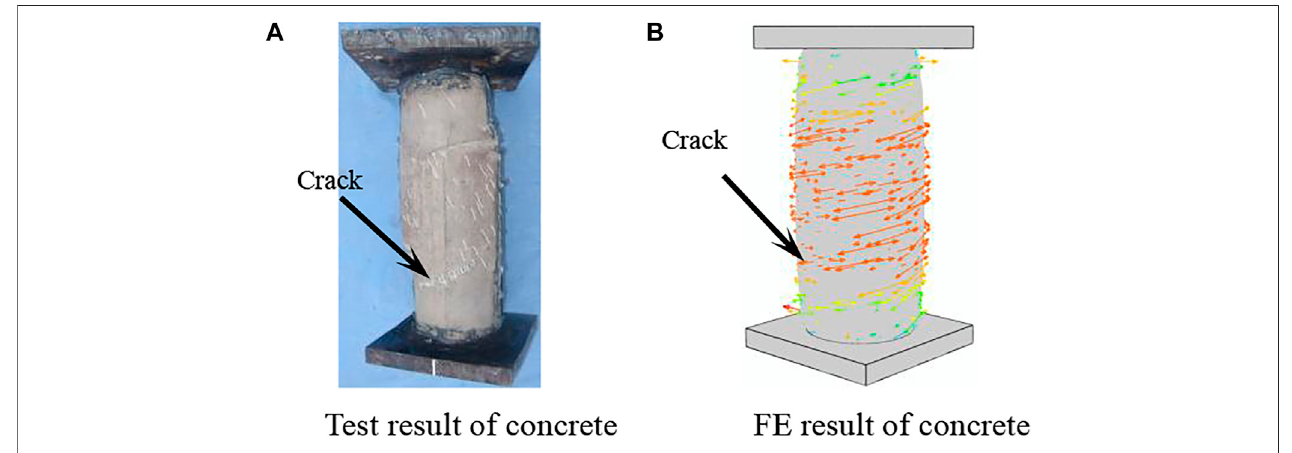
FIGURE 17 | Failure mode of concrete of the compression torsion specimen. (A) Test results of concrete, (B) FE results of concrete.